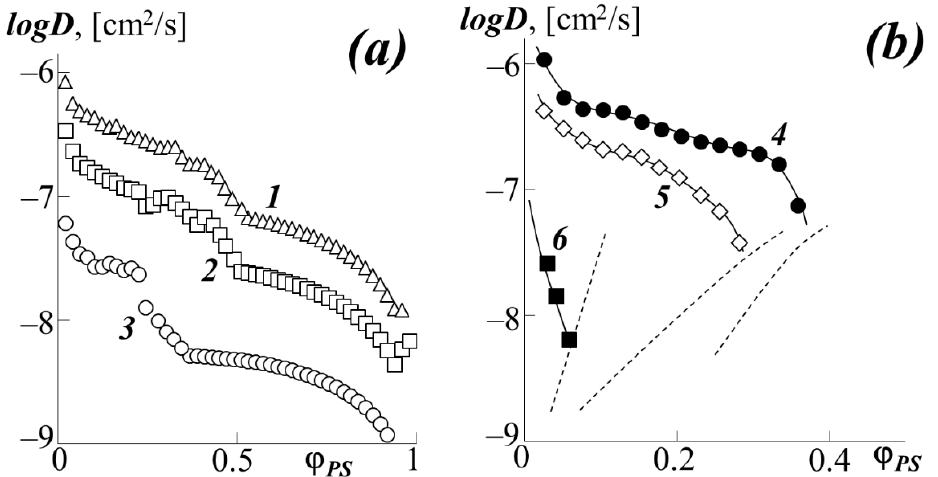
Figure 9. Concentration dependence of the diffusion coefficient at different temperatures ( a ) and for a number of acrylates at 433 K ( b ): 1–PBA–PS-1 at 433 K, 2–PBA–PS-1 at 413 K, 3–PBA–PS-1 at 373 K, 4–PEHA–PS-1, 5–PEA–PS-1, 6–PMA–PS-1. The dashed lines indicate the binodal curves of the corresponding systems.